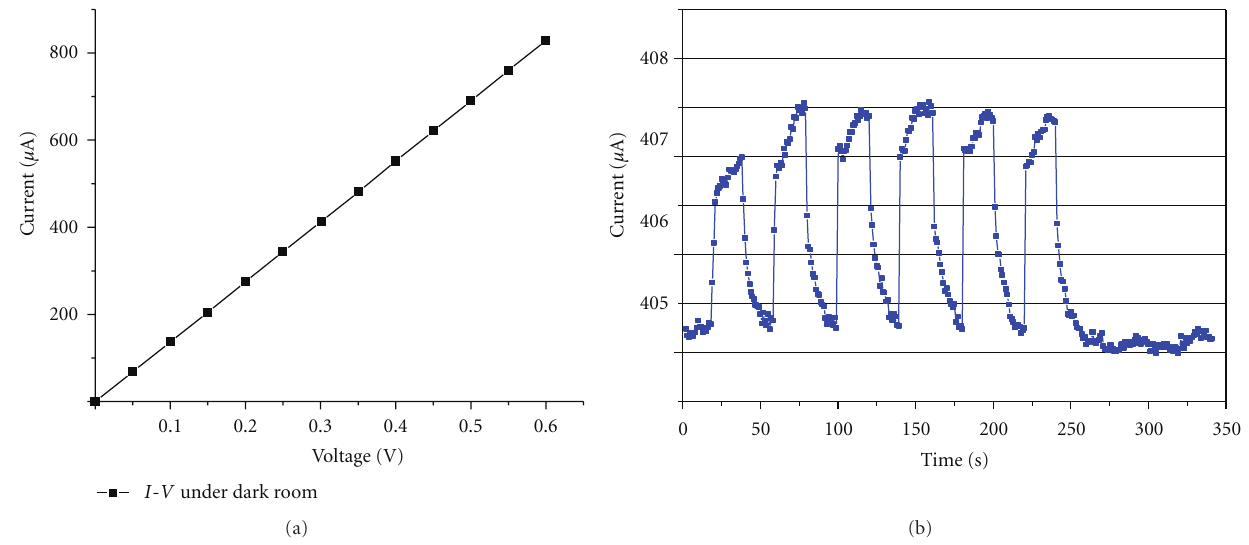
Figure 9: I - V characteristics of ZnO nanowires on chip fabricated by MVLS approach in dark (a) and the corresponding current-time switching response (b) under UV light illumination at constant voltage of 0.3